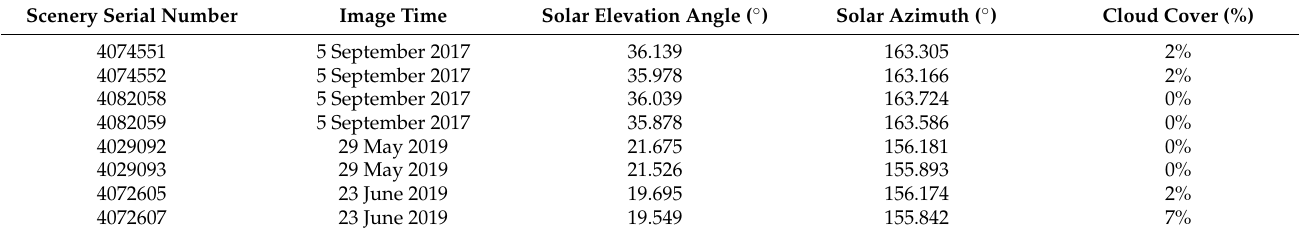
Table 2. Parameter information for GF-2 remote sensing images in the study area. Scenery Serial Number Image Time Solar Elevation Angle ( ◦ ) Solar Azimuth ( ◦